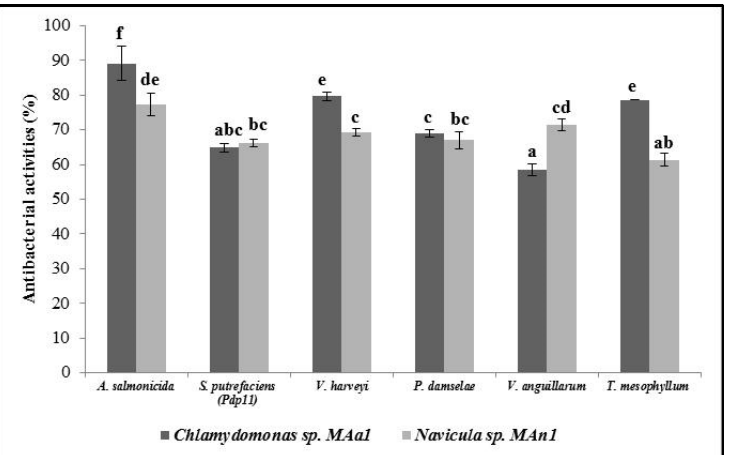
Figure 3. Antibacterial activities of Chlamydomonas sp. MA a1 and Navicula sp. MA n1 methanol extracts against V. harveyi , V. anguillarum , P. damselae , A. salmonicida , S. putrefaciens (Pdp11) and T. mesophyllum . Data show means ± SD ( n = 3). Statistical significance was determined by one-way ANOVA followed by Duncan multiple range test; significant difference ( p < 0.05) is indicated by different lowercase letters.